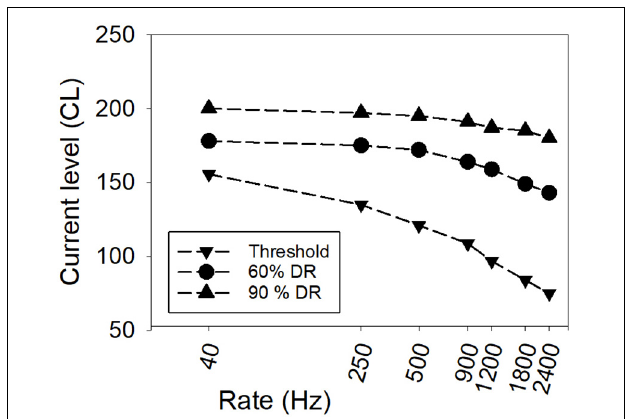
FIGURE 2 | An example from one CI user showing threshold and equal-loudness functions versus rate of stimulation. Currents are depicted in clinical current level (CL) units, where one CL is 0.176 dB (Data from McKay et al.,